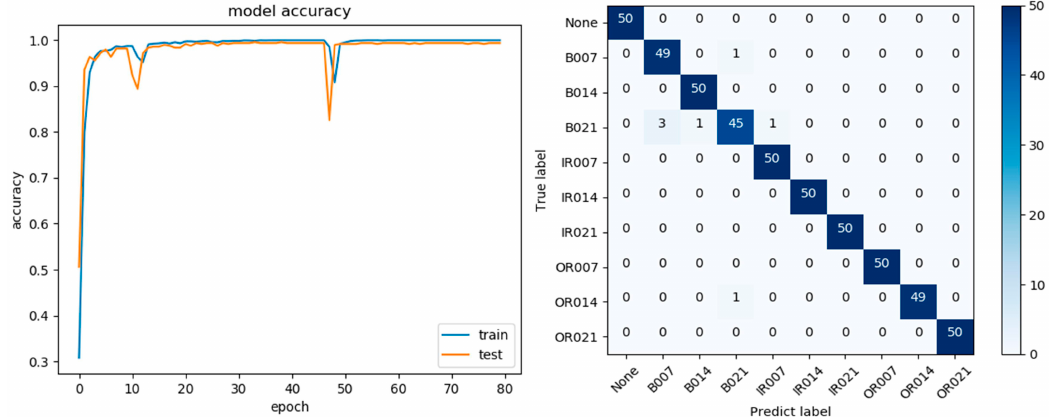
Appl. Sci. 2019 , 9 , x Figure 10. Diagram of the 1d-DCNN model ( a ) the training process and ( b ) confusion matrix; Figure 10. Diagram of the 1d-DCNN model ( left ) the training process and ( right ) confusion matrix.